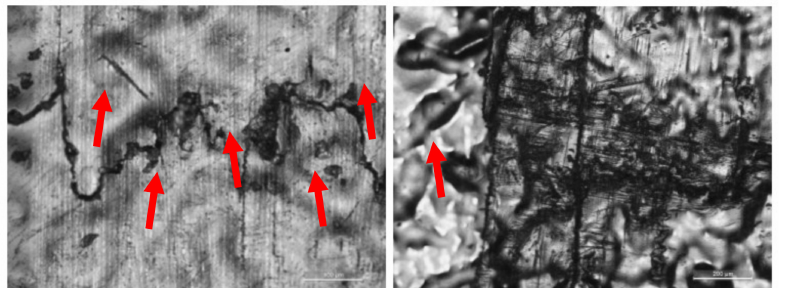
a matrix crack (Figure 12).